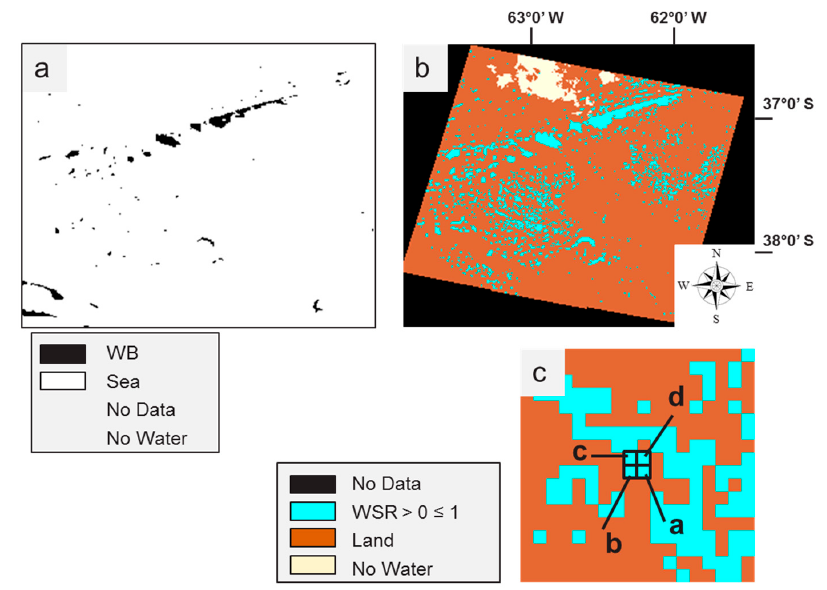
Figure C4. ( a ) The PROBA-V WB area extracted from 2nd dekad of November 2014, which corresponds with the downloaded Landsat 8 area. ( b ) The Water Surface Ratio (WSR) (PROBA-V spatial resolution) which is calculated using the Landsat 8 DTC result. ( c ) The four indicated pixels have a different WSR: (a) 0.7; (b) 0.03; (c) 0.02; and (d) 0.09. These four pixels are also overlaid on the images in the previous figure.